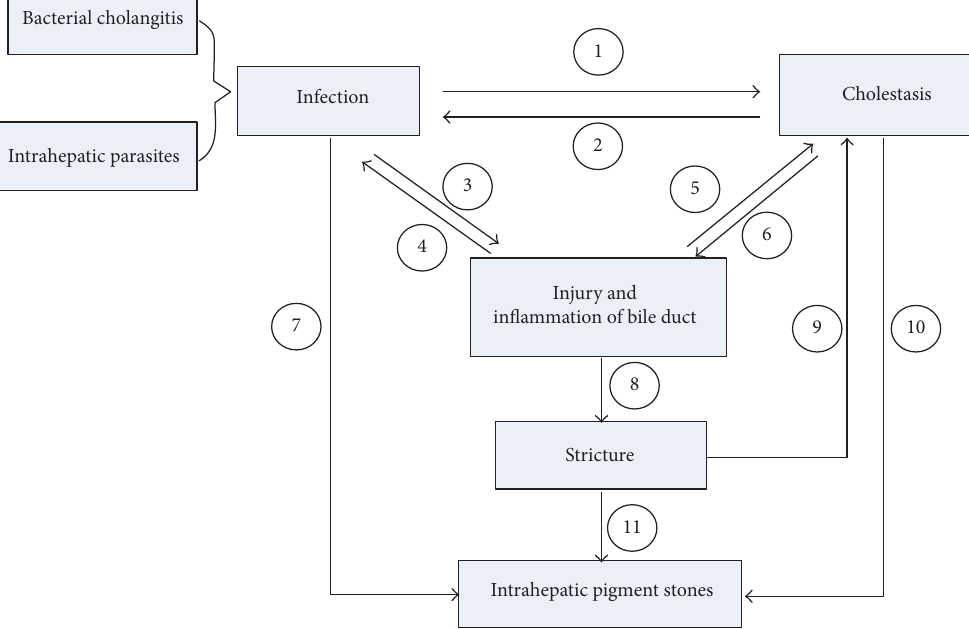
Figure 1: Causes of intrahepatic pigments stones and their relationships. Infection, cholestasis, and stricture are the three main causes of intrahepatic pigment stones. A Bacterial infection may influence the produce and transport of the bile and the worms or eggs of the parasites may lead to obstruction, resulting in cholestasis. B It is easier for bacteria to invade when cholestasis. C Bacteria or worms as well as their secretions are easy to induce the injury and inflammation of bile duct. D Bacterial cholangitis is inclined to occur after the loss of protective effects of normal bile duct. E 0 The pressure inside the bile duct changes when there is injury, inflammation, or stricture of bile duct, leading to cholestasis. F Cholestasis means toxic bile acid accumulated to cause biliary walls injury and inflammation. G Bacteria produce relevant substancesthatmaycausechangesofthecomponentsinbileandfinallydeposit. H Prolongedinflammationmaycausefibrosisofbiliarywalls, resulting in cholangitic stenosis. 1 Cholestasis provides time and place for the bile components deposited and then forms shaped stones. 2 The bile generates circumfluence and vortex above and below the stricture, providing additional power for small particles